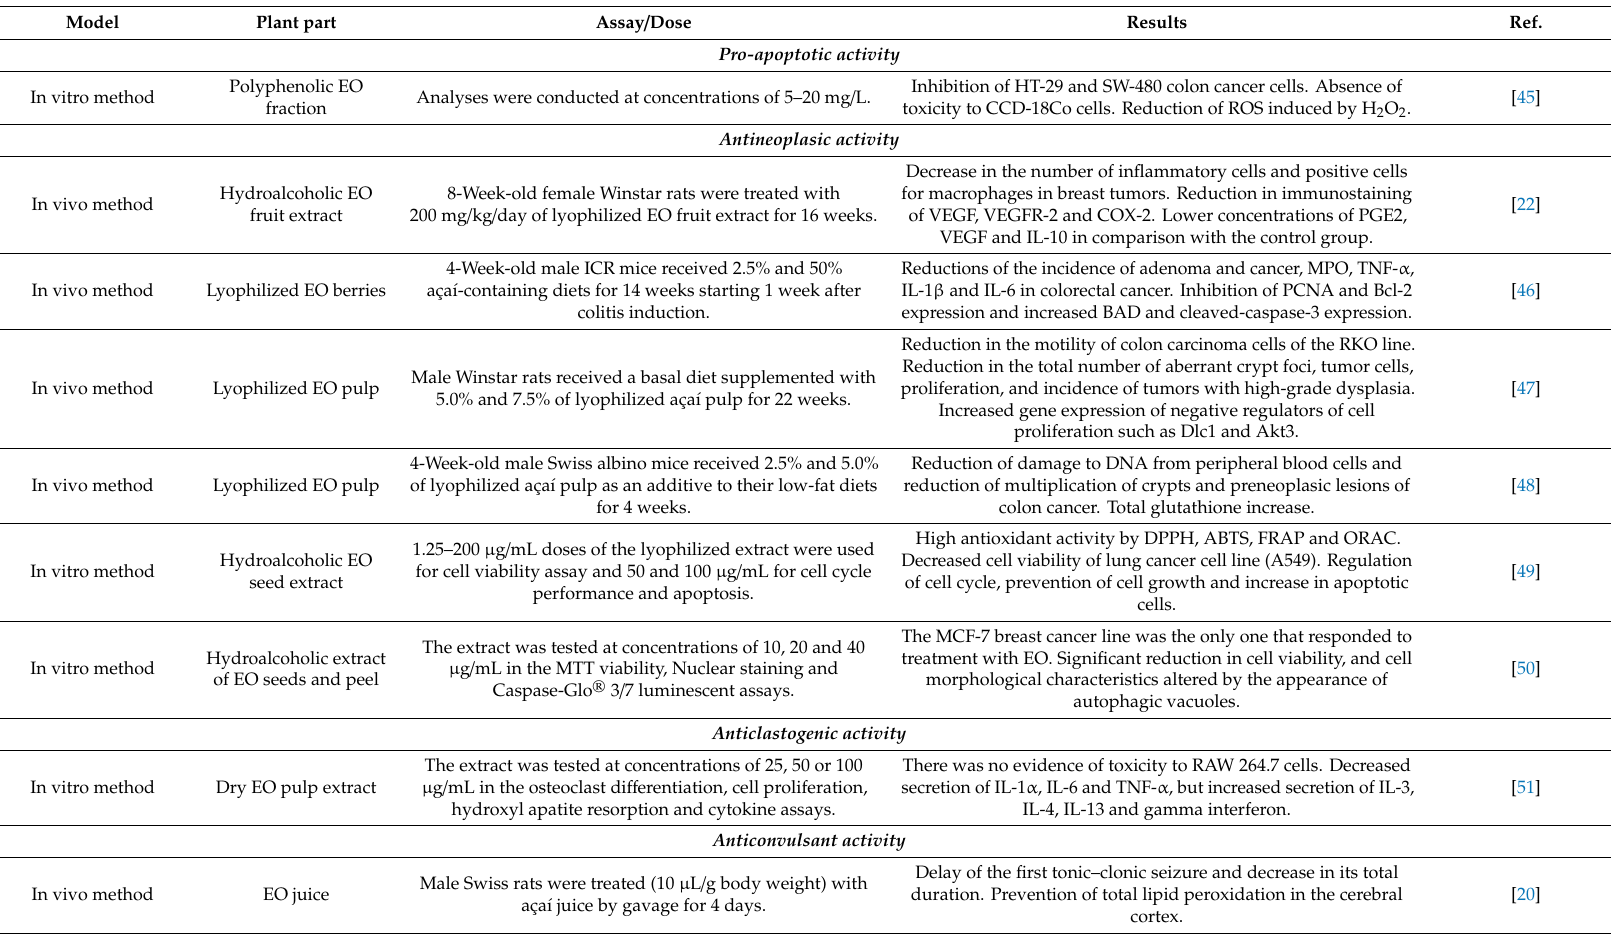
Table 2. In vitro and in vivo studies reporting the biological activities of di ff erent parts of Euterpe oleracea